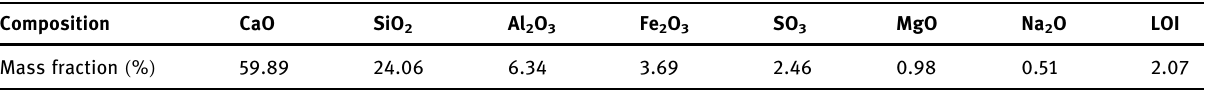
Table 1: Chemical composition of cement